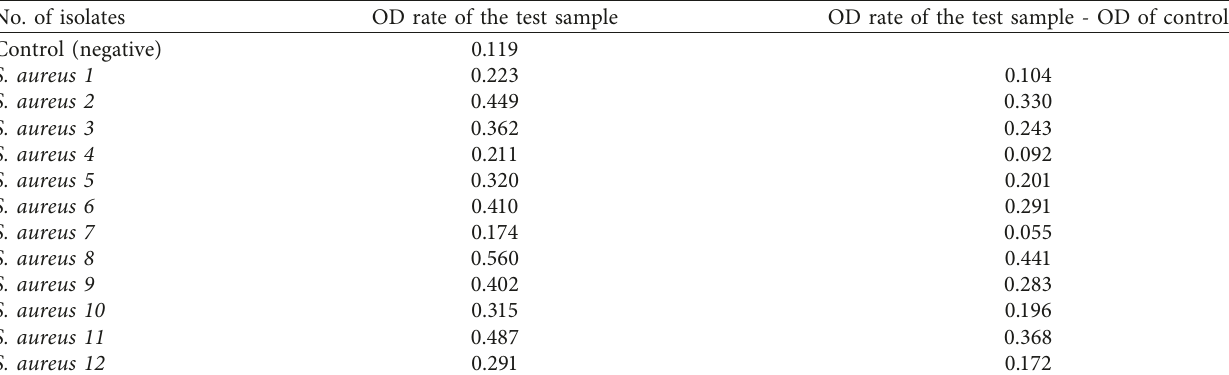
Figure 8: Biofilm production: qualitative assessment by adherence of S. aureus clinical isolates to microtiter plates; the degree of the biofilm was interpreted as weak, moderate, and strong biofilm formation as qualified in [28]. Table 3: In vitro biofilm production by S. aureus clinical isolates by the M.T.P method; the degree of the biofilm was interpreted as weak, moderate, and strong biofilm formation as qualified according to optical density (OD)